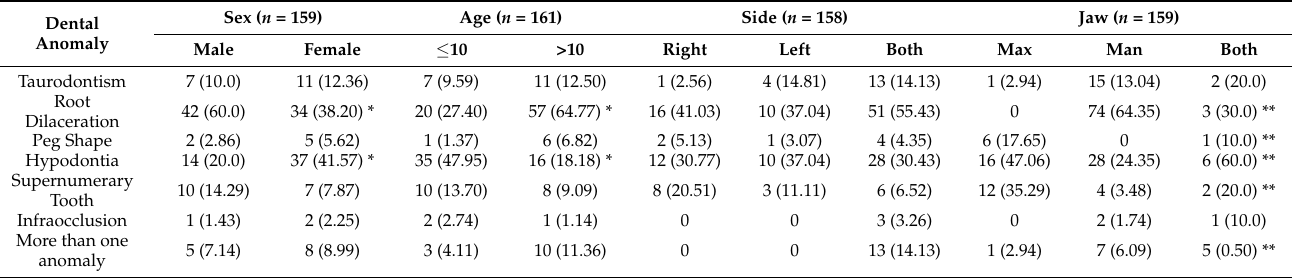
Table 2. Distribution of dental anomalies among sex and age ( n = 161).